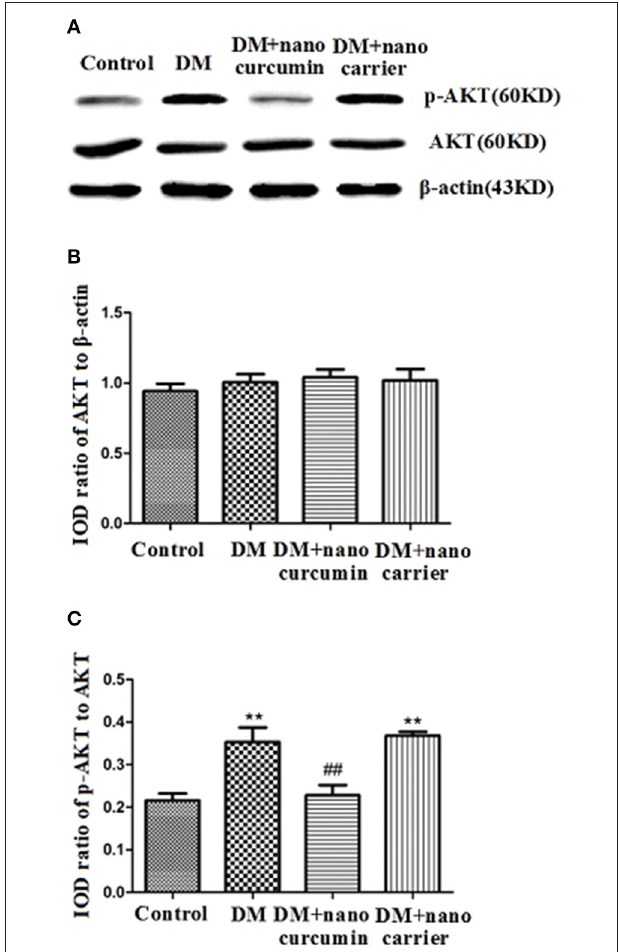
FIGURE 7 | Effects of nanoparticle-encapsulated curcumin on p-AKT levels in the DRG of DM rats. (A,B) Ratios of Akt to β -actin integrated optical densities (IODs) were not significantly different between the DM group and the control groups ( p > 0.05). (A,C) The ratio of the p-Akt to Akt IODs was higher in the DM group than that in the control group ( p < 0.01, n = 7 for each group). The ratio of the p-AKT to AKT IODs was significantly increased in the DM group compared to that in the control group ( p < 0.01). (A,C) The ratio of p-Akt to Akt IODs in DM rats treated with nanoparticle-encapsulated curcumin was significantly decreased compared with that in the untreated DM group ( p < 0.01, n = 7 per group). Data are displayed as means ± SEMs, n = 7. ** p